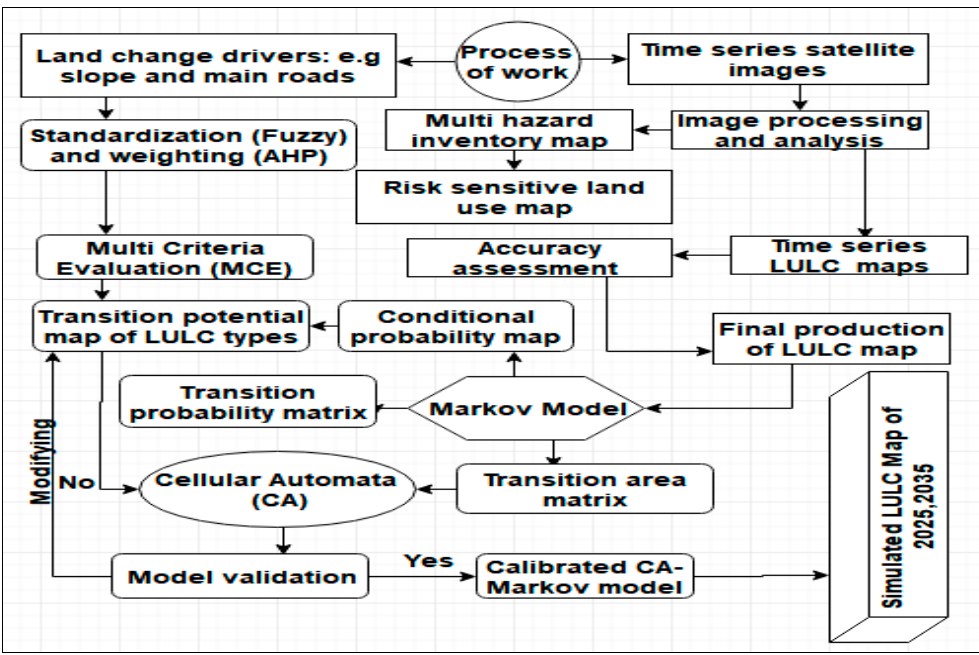
Figure 2. Research design.